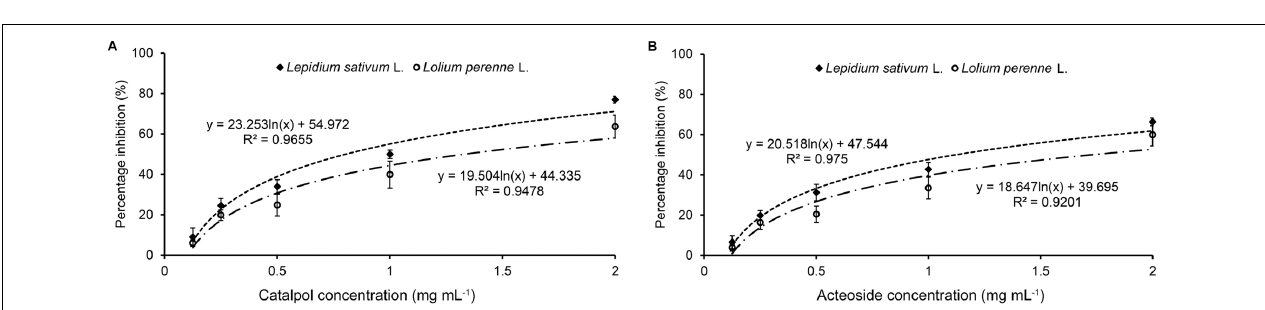
FIGURE 5 | Quantification of catalpol (A) and acteoside (B) in various tissues of R. glutinosa tubers. Different letters indicate statistical difference ( p < 0.05).